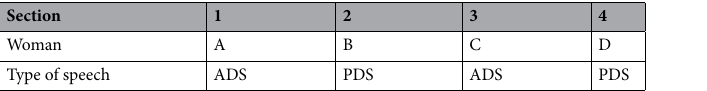
Table 1. Example composition of a stimulus film. A film lasted two minutes and was divided in four sections. During each section a same sentence was repeated four times. The orders of the types of speech, along with which type of speech each woman was using for each horse, were